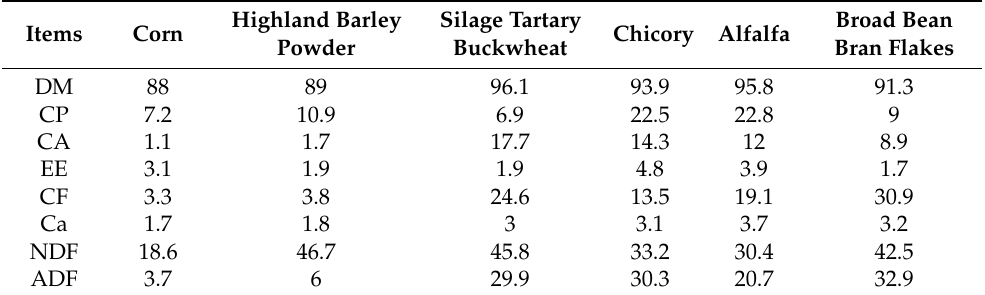
Table 5. Nutrient composition of raw materials in the original diet of Diqing Tibetan pigs (October, air-dry basis), %.